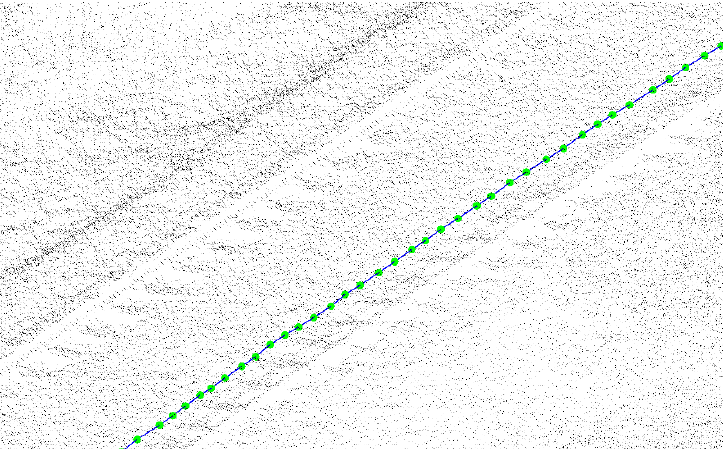
Figure 6. Example of a three-dimensional line extracted, representing the sensor trajectory.